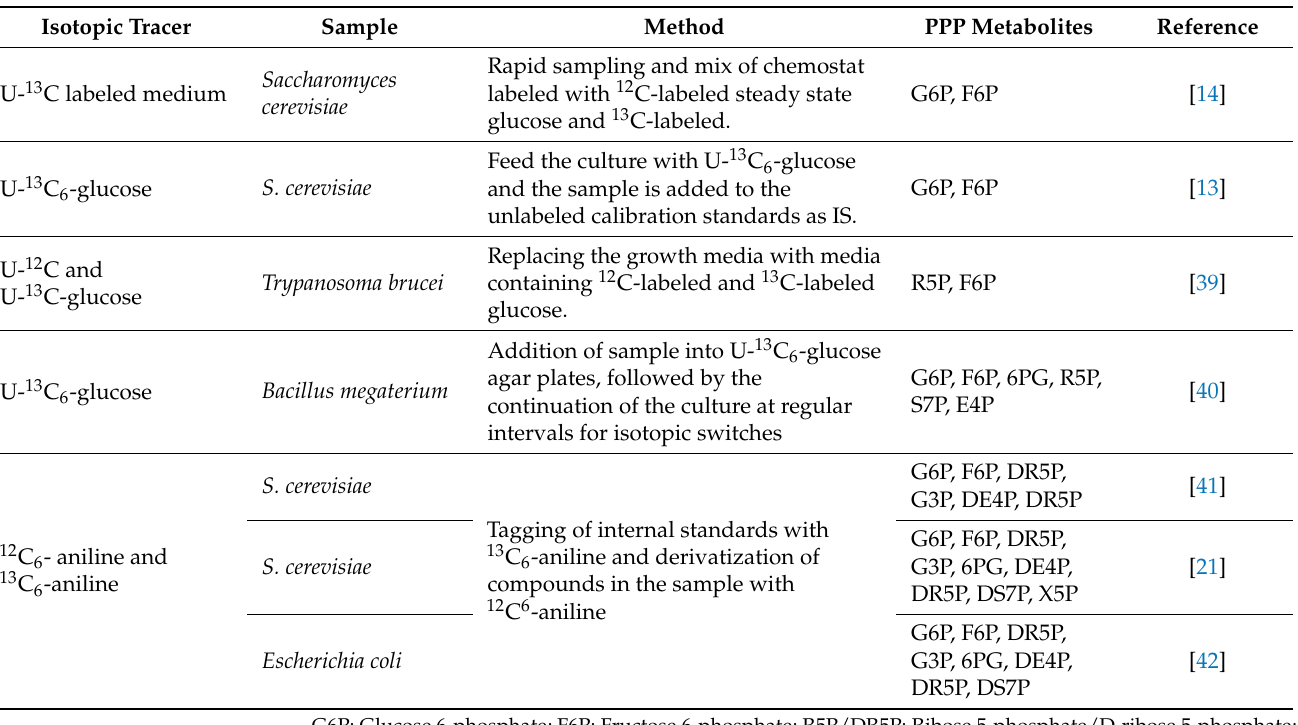
Table 1. Absolute quantification of pentose phosphate pathway (PPP) metabolites of microbial samples using the isotope labeling